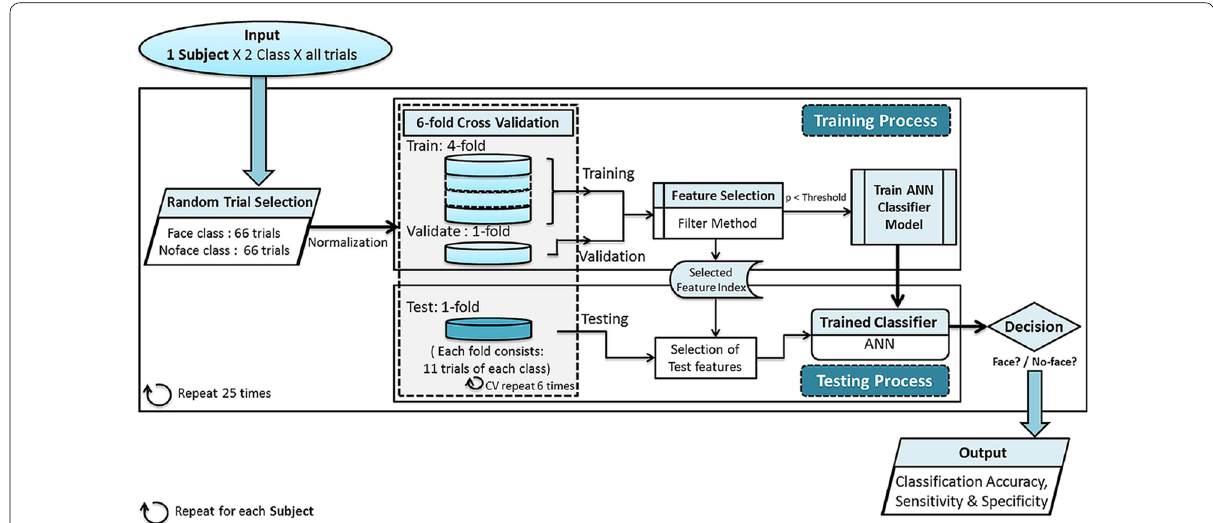
Fig. 4 Block diagram of classification process for personalized average model: all trials of each subject were proceeded to the main classification block. Random downsampling was performed to remove data imbalance from face and no-face classes. Then typical machine learning classification process was executed with sixfold nested cross-validation technique. Here simple filter feature selection technique ( t test) was followed by artificial neural network for the two class problem. Finally, the outcomes are classification accuracy, sensitivity and specificity of each